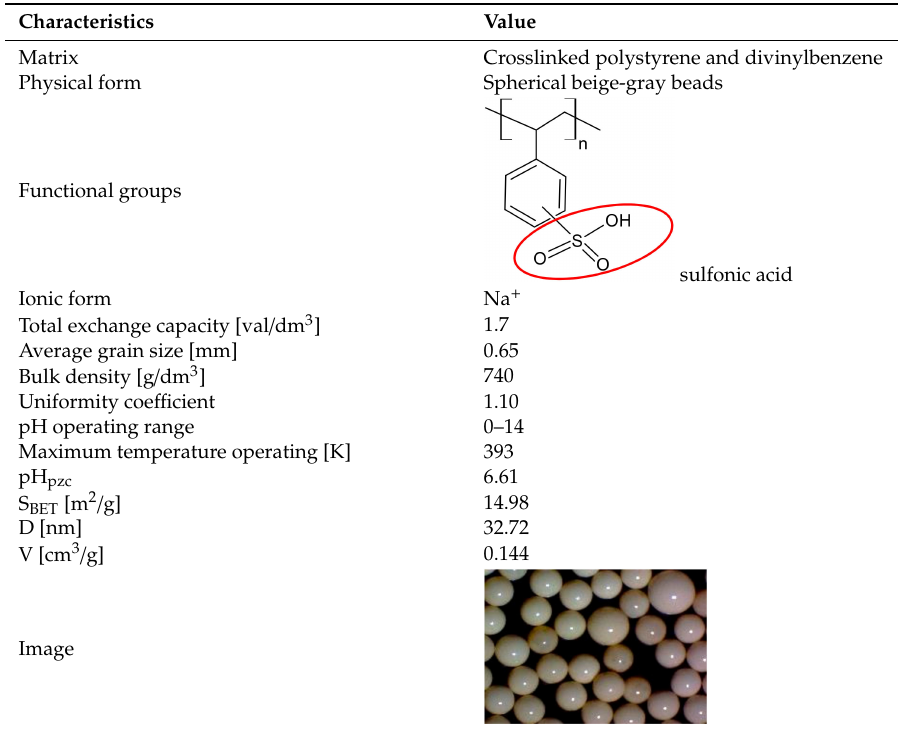
Figure 3. SEM micrographs of Lewatit Monoplus SP112 ( a ) spherical shape of ion exchanger, ( b ) before and ( c ) after La(III) loading. Table 1 summarizes the values of obtained parameters. Table 1. Characteristics of Lewatit Monoplus